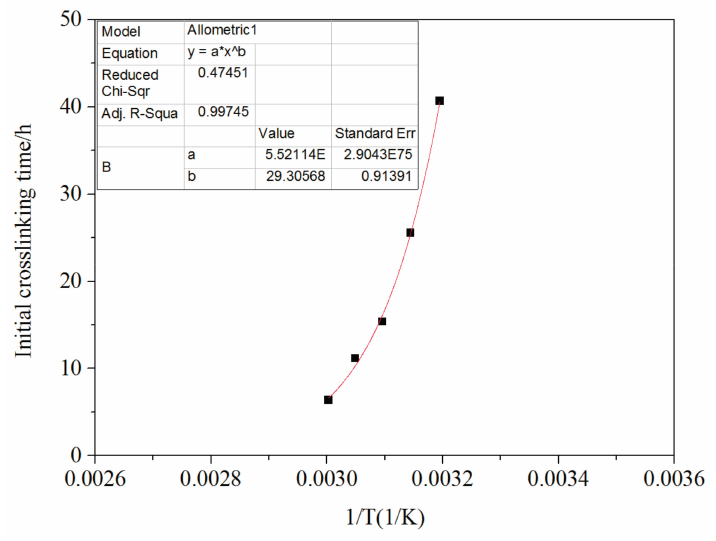
Figure 13. Effect of temperature on the initial gelation time of the polymer